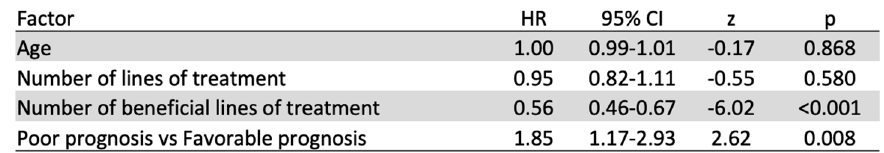
Figure 4. A greater number of beneficial therapies received correlated with longer OS. Kaplan–Meier OS curves for patient cohorts defined by the total number of beneficial lines of treatment received (independent of total number or duration of treatments). Subpanel: Pairwise statistical comparison of the duration of OS between the five subgroups receiving zero, one, two, three, and four beneficial lines of therapy.